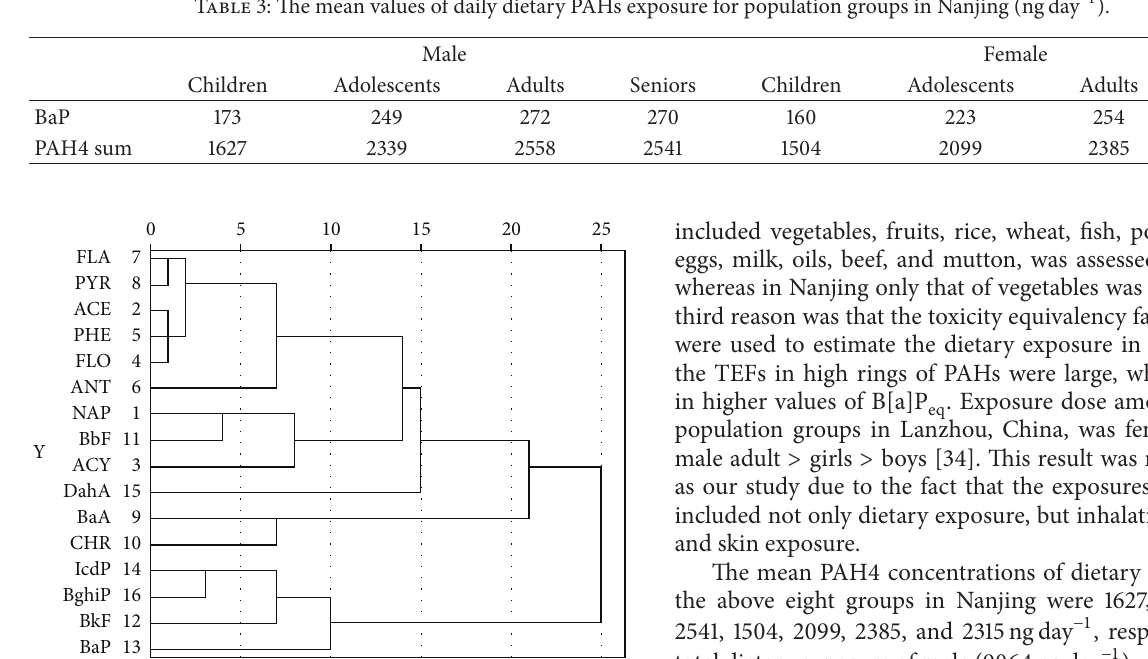
Table 3: The mean values of daily dietary PAHs exposure for population groups in Nanjing (ngday −1 ).